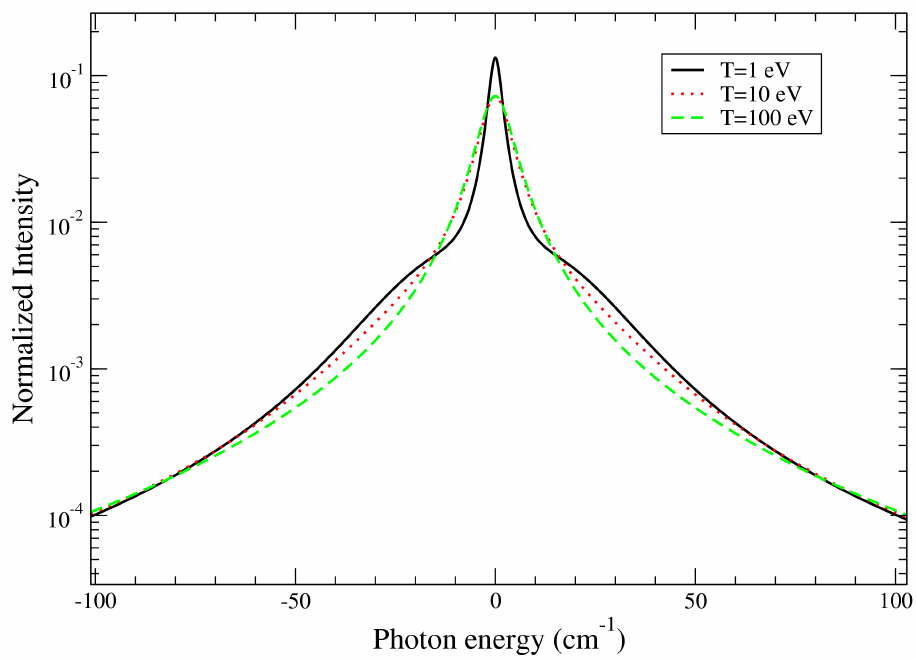
Figure 8. Same as Figure 7 for the dynamic Lyman- α line shapes of